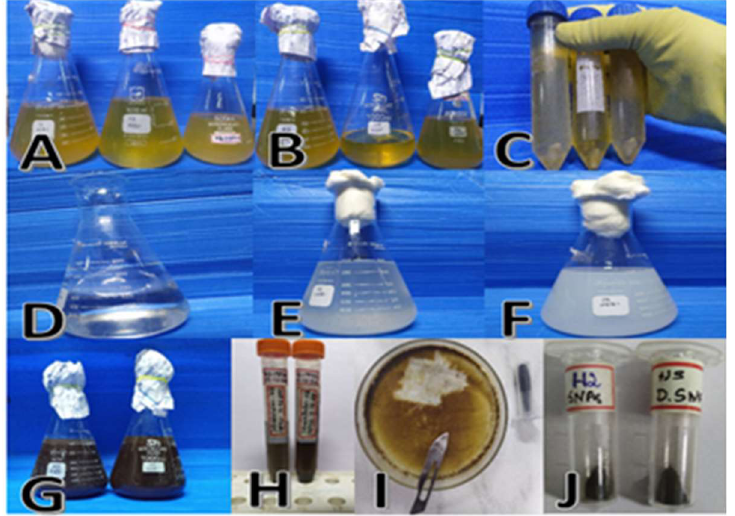
Figure 2. Synthesis of silver nanoparticles using Pantoea stewartii and Priestia aryabhattai (( A )— bacterial broth culture of Pantoea stewartii ; ( B )— Priestia aryabhattai ; ( C )—bacterial pellet; ( D )—distilled water; ( E )—bacterial pellet and distilled water; ( F )—bacterial pellet, distilled water, and 1 mM silver nitrate; ( G )—broth changed to dark brown color, indicating silver nanoparticle synthesis; ( H )— separated nanoparticle; ( I )—dried silver nanoparticles; ( J )—powder form of silver